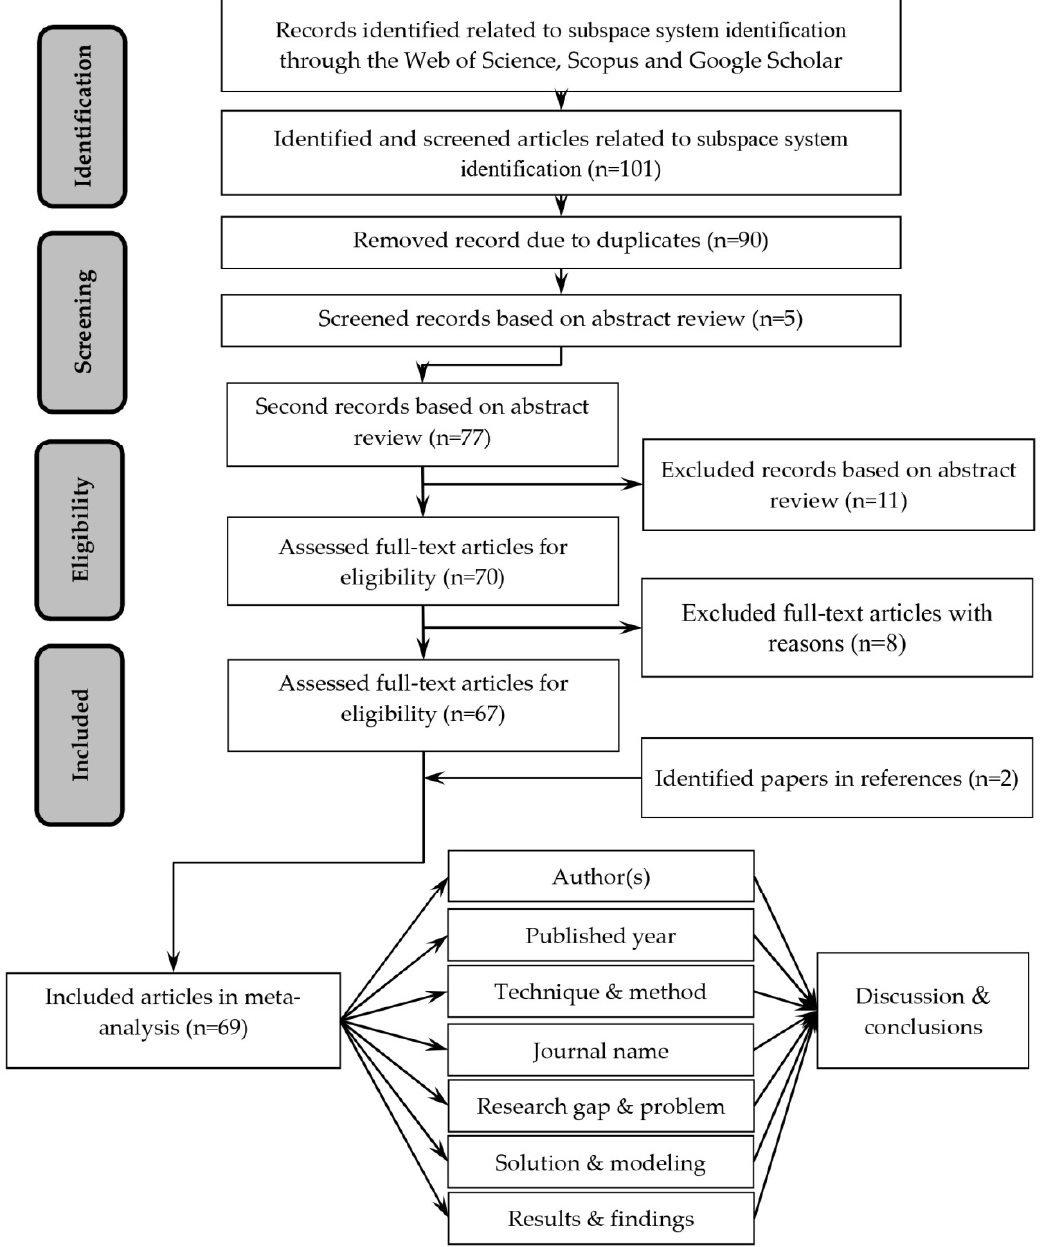
Figure 4. Study flowcharts for the identification, screening, eligibility and inclusion of